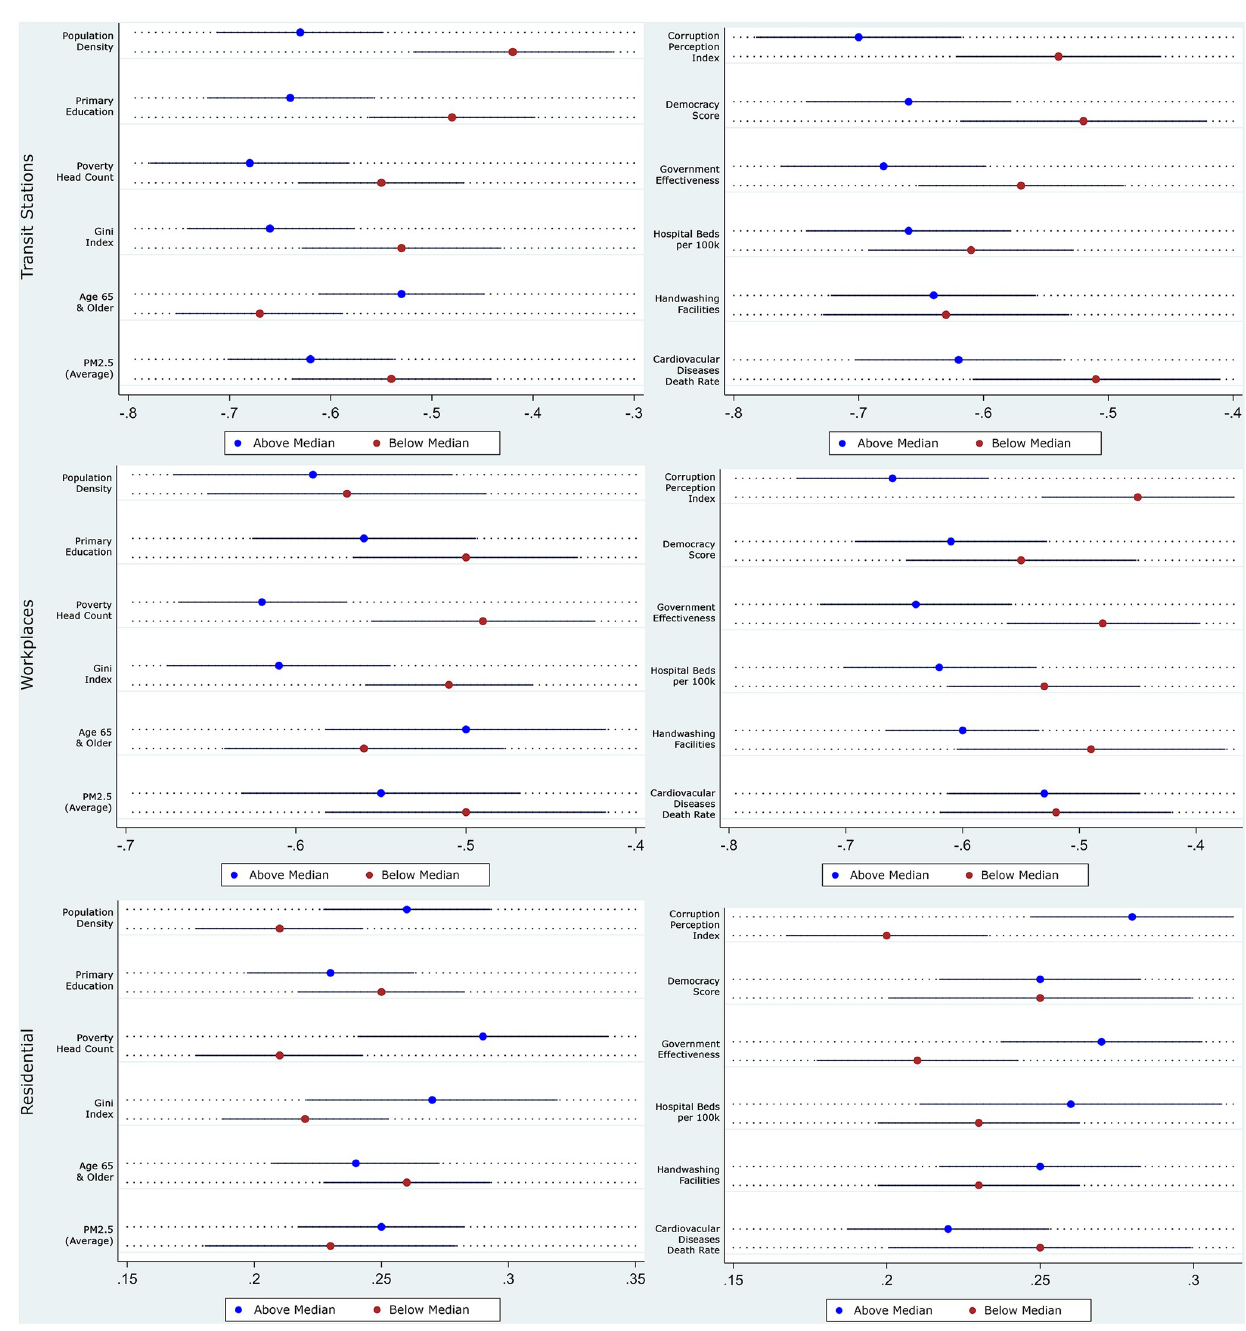
Fig 2. Coefficient plots of hetegeneous impact of stricter restriction on mobility. Coefficient plots are constructed using results from Tables 4 and 5 with 90% confidence intervals.